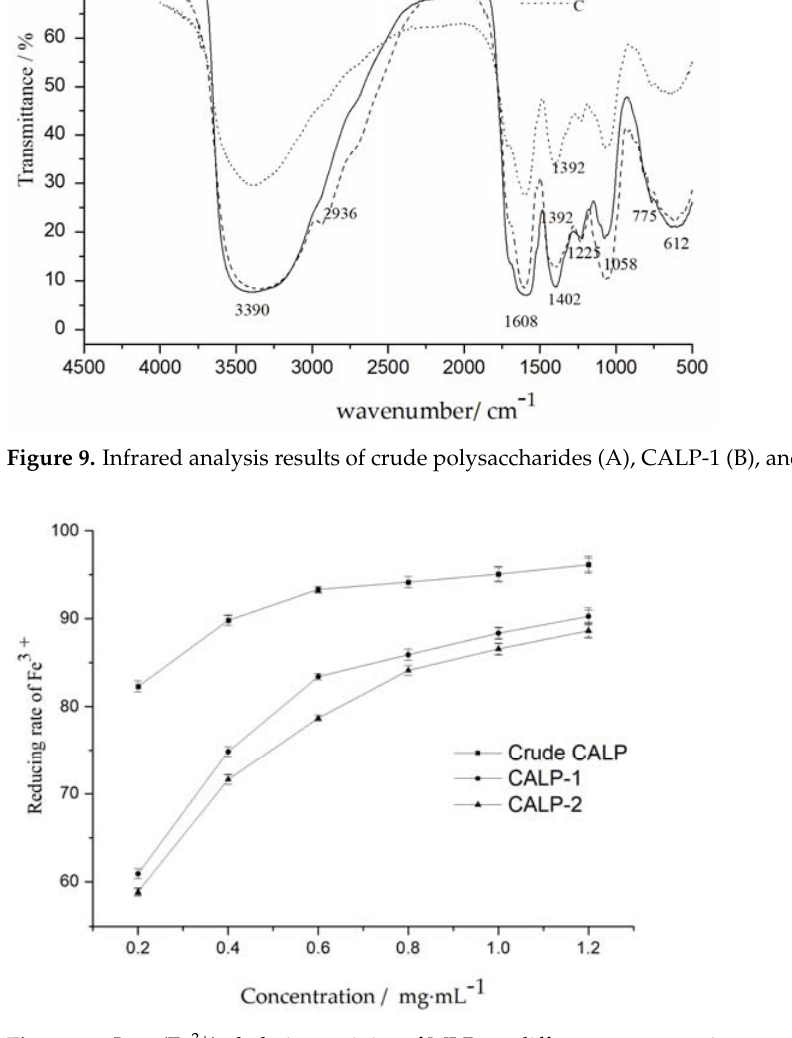
Figure 9. Infrared analysis results of crude polysaccharides (A), CALP ‐ 1 (B), and CALP ‐ 2 (C).